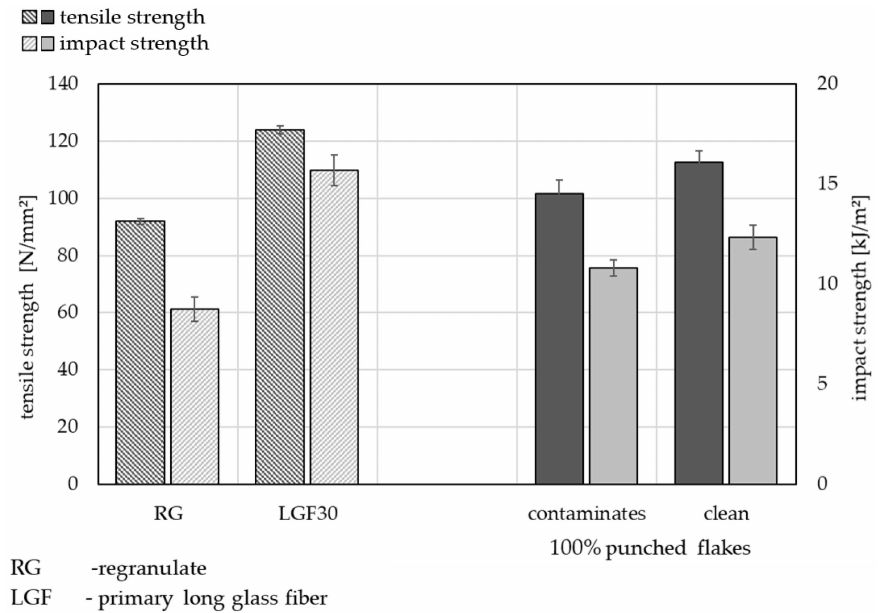
Figure 8. Influence of the impurity from the waterjet-cutting process on the mechanical properties (tensile strength and impact strength) in the processed materials (with punched flakes only) in comparison with the references RG and